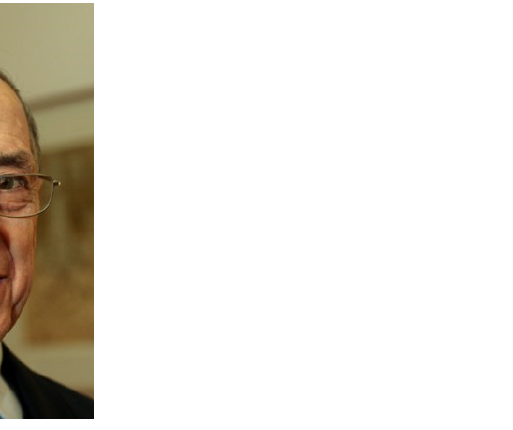
Figure 1. Professor Sir Peter J. Lachmann, 1931–2020 (Courtesy of Christ’s College, Cambridge).